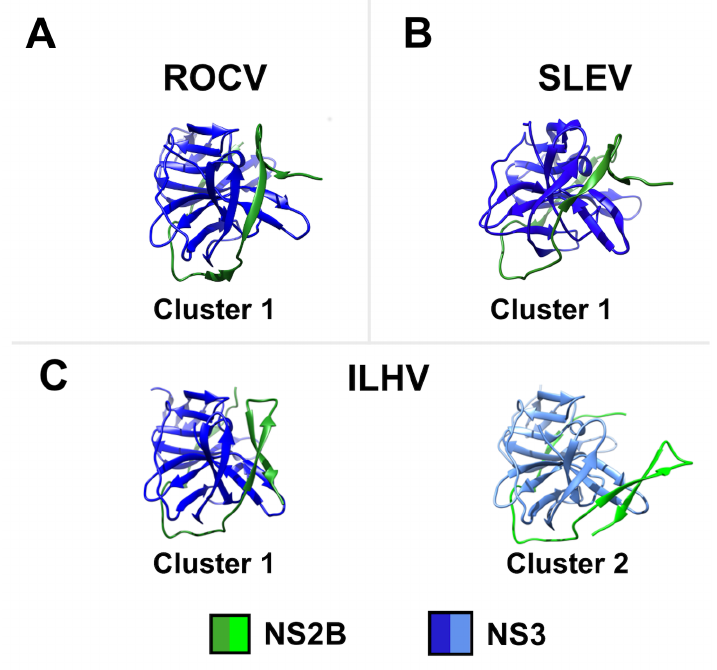
Figure 2. Ribbon conformation of clusters of ( A ) Rocio virus, ( B ) Saint Louis encephalitis, ( C ) Ilhéus virus. The NS2B and NS3pro domains are shown in green and blue, respectively.